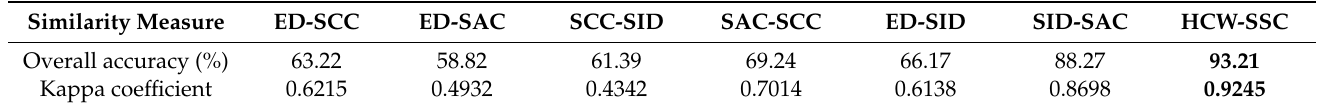
Table 7. Overall accuracy and kappa coefficient of each hybrid kernel based on OMIS HSI (the gray area has the results from Table 4, Euclidean distance–spectral correlation coefficient (ED-SCC), Eu- clidean distance–spectral angle cosine (ED-SAC), spectral correlation coefficient–spectral information divergence (SCC-SID), spectral angle cosine–spectral correlation coefficient (SAC-SCC), Euclidean distance–spectral information divergence (ED-SID), spectral information divergence–spectral angle cosine (SID-SAC), and a new hybrid changing-weight classification method with a filter feature selection (HCW-SSC)). The numbers in bold mean the most important results.